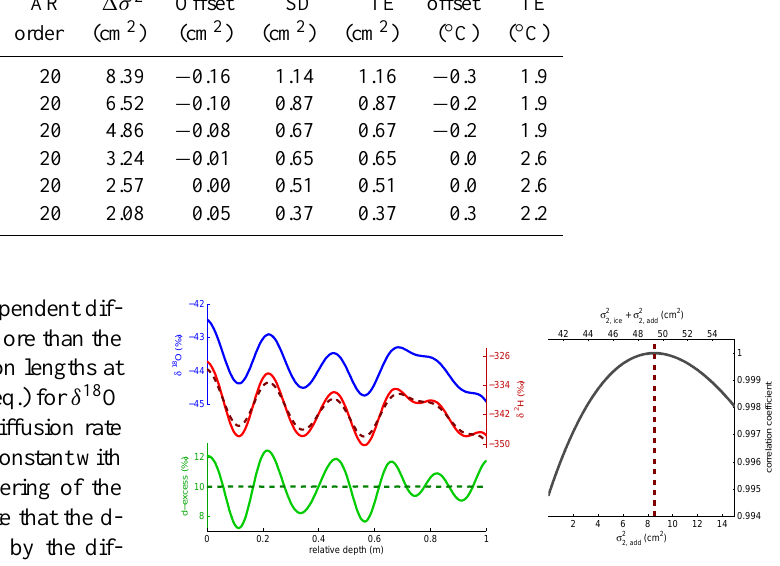
Figure 5. Illustration of the correlation method for ideal conditions in which the correlation coefficient of the isotope data before dif- fusion is 1. The δ 18 O, δ 2 H and d-excess signals after firn diffusion has taken place are depicted by the solid lines in the left figure. The dashed lines show the δ 2 H and d-excess profiles after the δ 2 H pro- file is diffused further until the total δ 2 H diffusion length equals that of δ 18 O. In the figure on the right the correlation coefficient between δ 18 O and δ 2 H is given as a function of the additional dif- fusion length as the δ 2 H profile is diffused